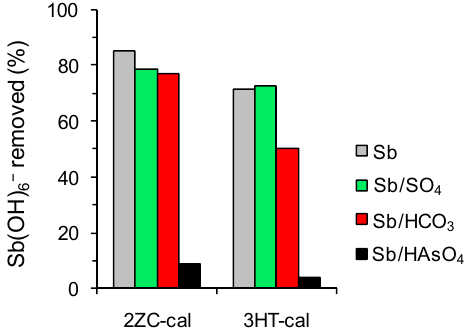
Figure 1. Percentage of Sb(OH) 6 − removed from solution by 2ZC-cal and 3HT-cal at the end of the experiments without competitors (Sb) and with HCO 3 − (Sb / HCO 3 ), SO 42 − (Sb / SO 4 ) or HAsO 42 − (Sb / HAsO 4 ) as coexistent anions.